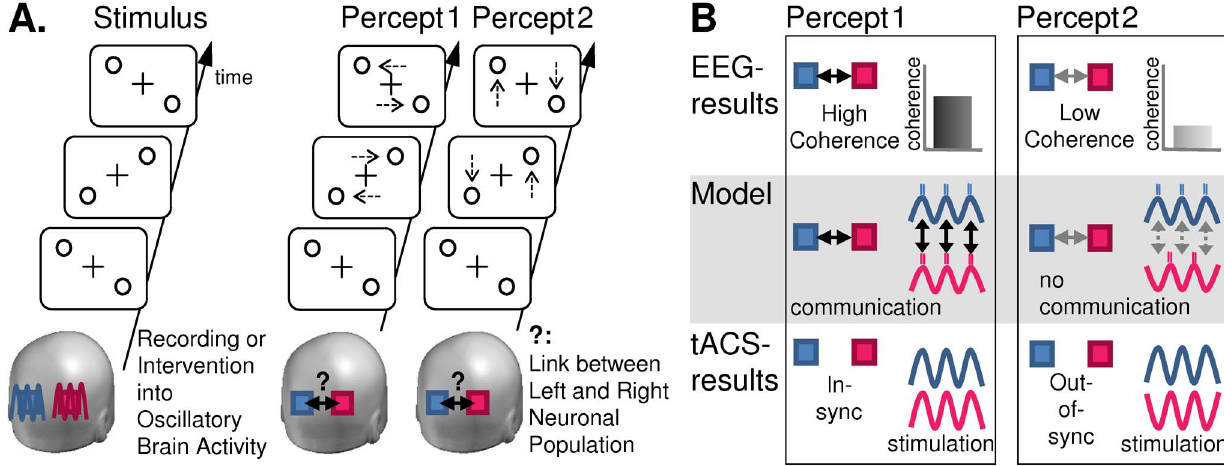
Fig. 1. Schematic representation of design, objectives, and insights from the study by Helfrich et al. A. Design and questions : Participants viewed an apparent motion stimulus, which elicits a bistable percept consisting of either horizontal (percept 1) or vertical motion (percept 2). A bi-hemispheric network of two posterior areas (blue and red squares) was interrogated as to the functionality of inter-area synchrony (see ‘‘?’’) in generating these percepts, by recording of brain oscillations through electro-encephalography (EEG), and interventions into these oscillations through transcranial alternating current stimulation (tACS). B. Results and conclusion : EEG revealed that the horizontal motion percept was associated with enhanced synchrony (coherence) between oscillatory brain activity of the two posterior areas (as compared to vertical